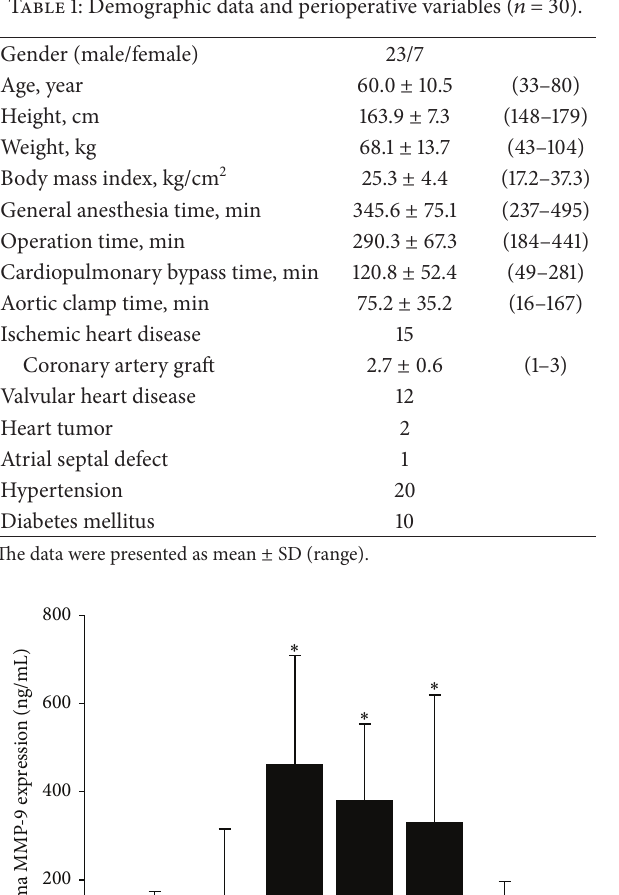
Table 1: Demographic data and perioperative variables ( 𝑛 = 30).